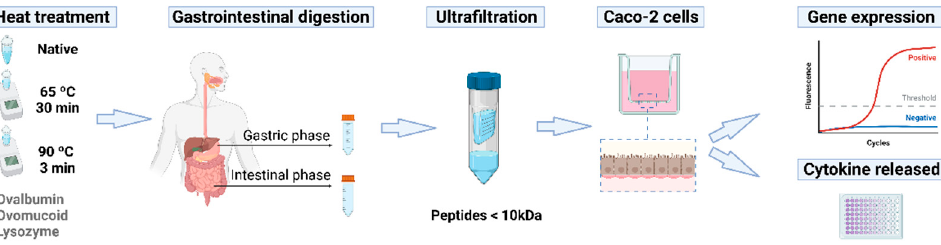
Figure 1. Schematic presentation of the experimental protocol used in this study for the determination of the cytokine production in Caco-2 cells after stimulation with peptides generated during gastrointestinal digestion of heated egg white proteins. Reproduced or adapted from [14], with permission from BioRender, 2022.